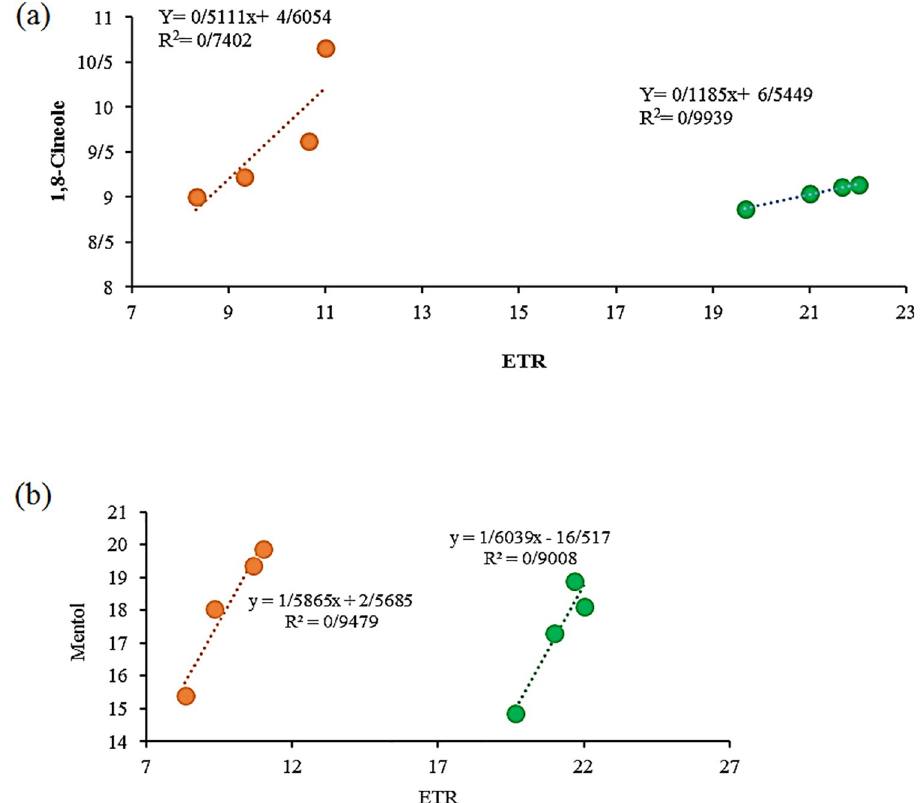
Fig 14. Relationship between some metabolites in inoculated and non-inoculated peppermint with ( P . indica , AMF and co-inoculation) under 9 dsm -1 salinity stress in peppermint plant. The salinity and non-salinity condition were indicated in orange and green,